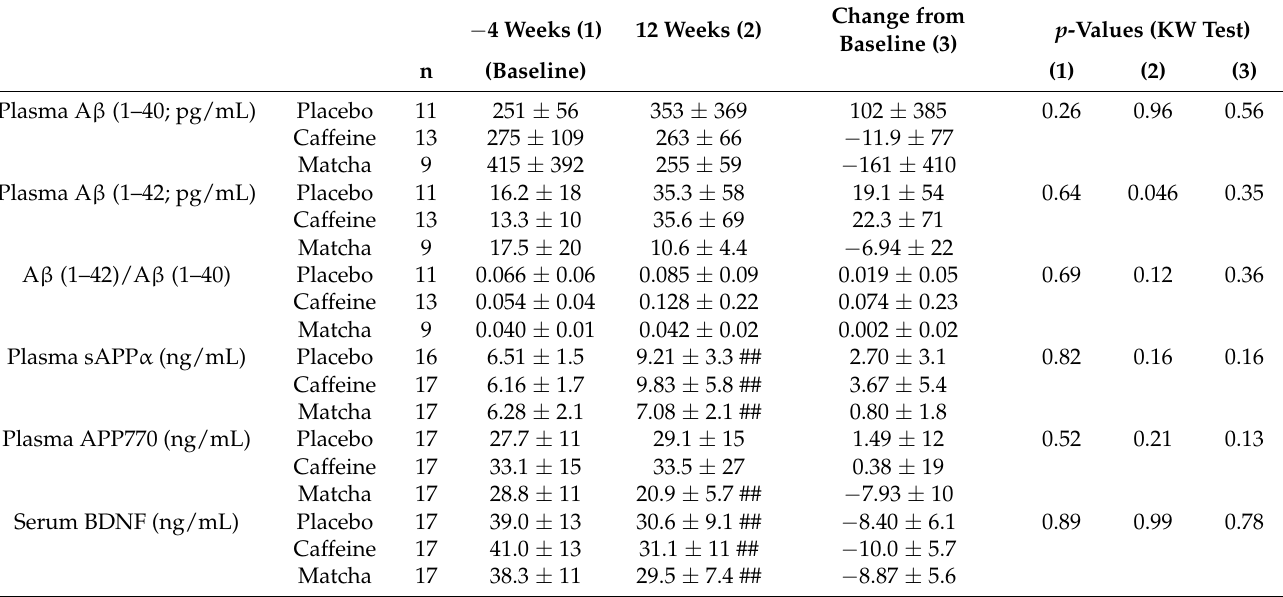
Table 10. Effect of matcha or caffeine intake on dementia-related blood